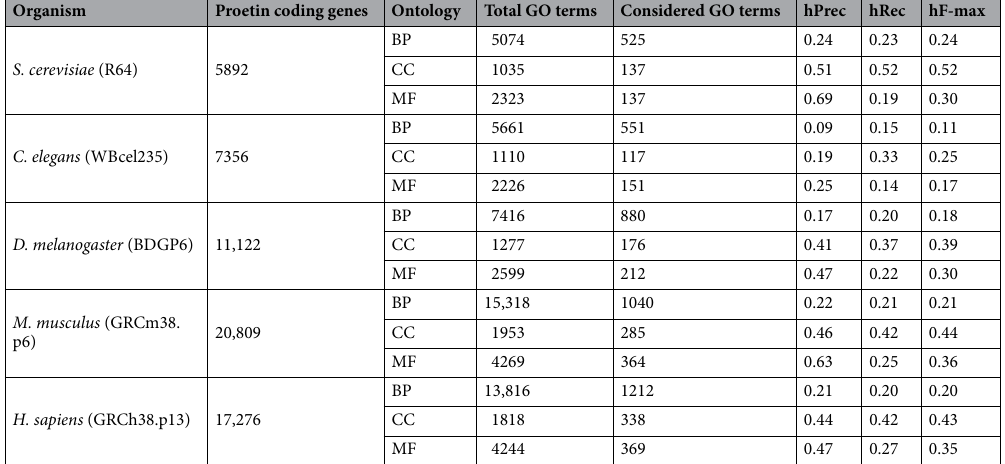
Table 1. GO terms for which a binary classifier was trained and tested. The first column shows the assembly version used for each organism, the second column shows the number of protein coding genes in each genome, the third column indicates the ontology, the fourth column shows the number of GO terms associated with at least one gene for that organism and ontology and the fifth column shows the number of GO terms associated with at least 40 genes in the set T (used for training) and 10 genes in the set E (used for evaluation). These are the GO terms for which a binary classifier was trained and tested. For each organism and ontology, we implemented a hierarchical multilabel classifier combining these binary classifiers. Columns six, seven and eight show the hierarchical precision, recall and F-max reached by each of these models respectively.